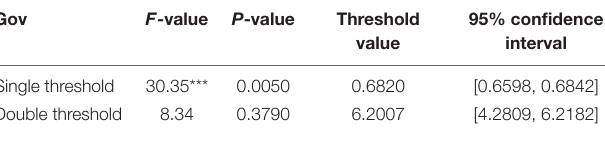
TABLE 6 | Results of the threshold effect